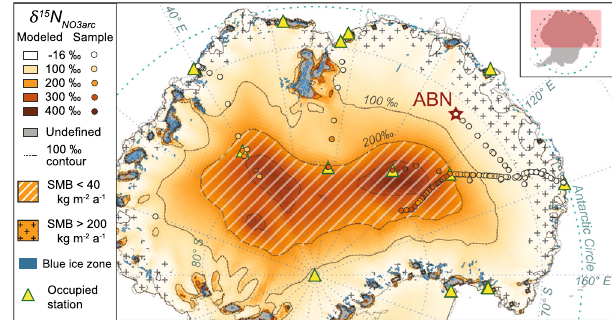
Fig. 3 δ 15 N NO3arc values modeled by (1) across East Antarctica based on surface mass balance (SMB). The spatial variability of δ 15 N NO3arc values across East Antarctica are modeled by applying the fi eld data regression of ln( δ 15 N NO3arc + 1) vs. SMB − 1 to the 1979 – 2015 mean SMB output (35 km resolution) from the MAR 13 , adjusted for dry site bias (see Methods). Values of δ 15 N NO3arc are unde fi ned (gray) at some locations near the coast with very low or negative SMBs due to high sublimation and wind scouring. Preservation of NO 3 − is not expected in these locations, which often correspond to blue ice zones (blue polygons, zones with >100 km 2 extent shown) 76 . Samples of δ 15 N NO3arc from the fi eld database are illustrated by colored circles with the same color gradient as the modeled δ 15 N NO3arc values. Regions with SMB less than or greater than 40 – 200 kg m − 2 a − 1 (i.e., the SMB range targeted by the δ 15 N NO3arc proxy described here) are illustrated with hatching and crosses, respectively. Presently occupied stations in the CONMAP database are shown as triangle icons for spatial reference, and the Aurora Basin North (ABN) site is indicated with a red